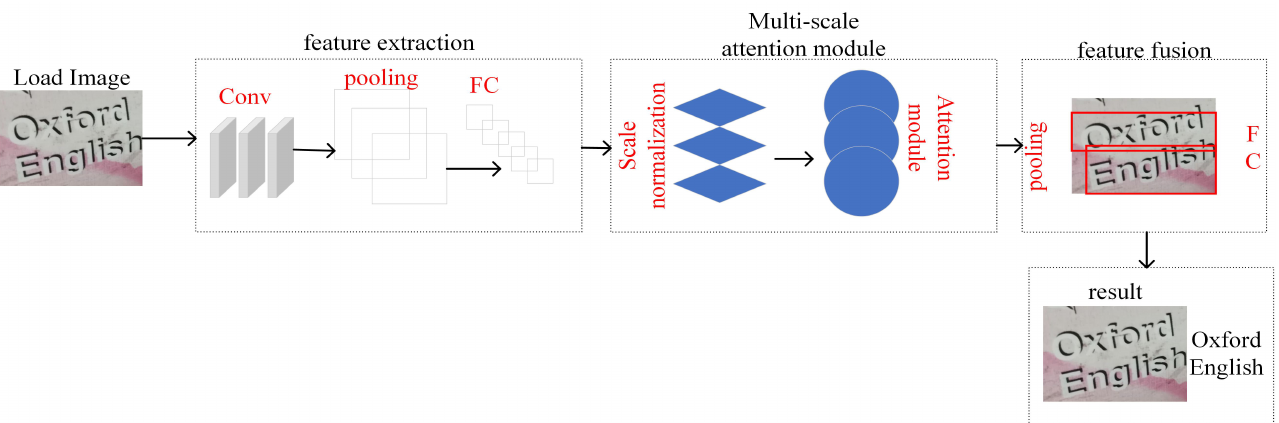
Figure 1. Overall flow chart of